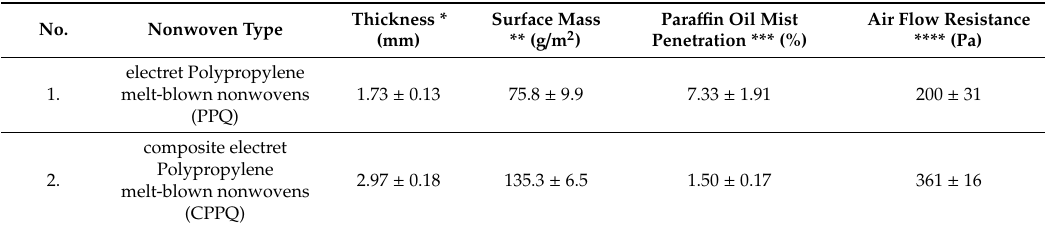
Table 1. Characteristics of filtering